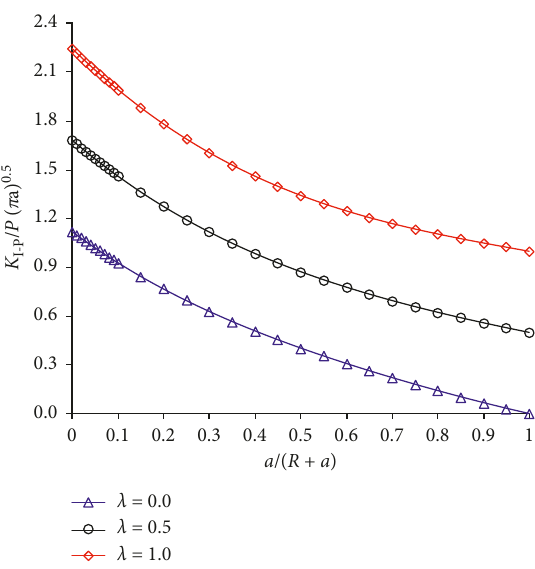
Figure 4: Normalized mode-I stress intensity